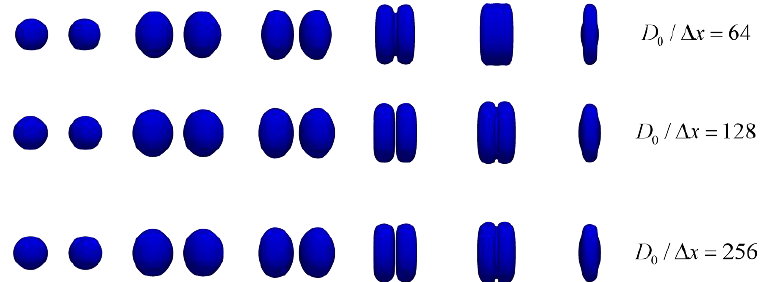
Figure 3. The adaptive mesh generated by interDyMFoam.